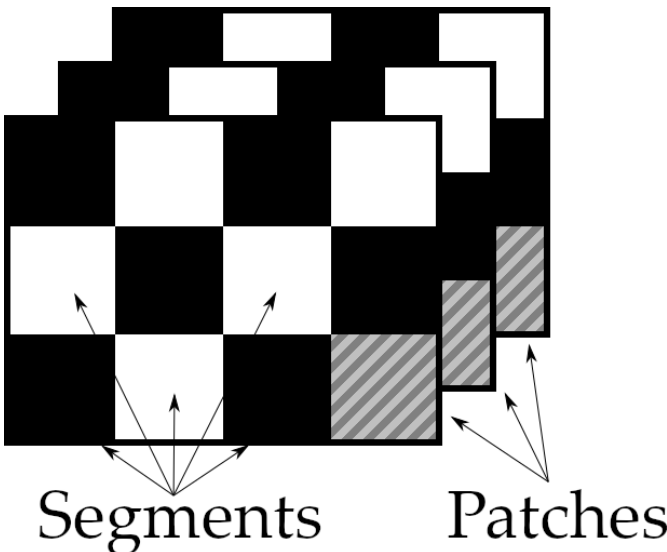
Figure 4. Division of the frames to patches for local